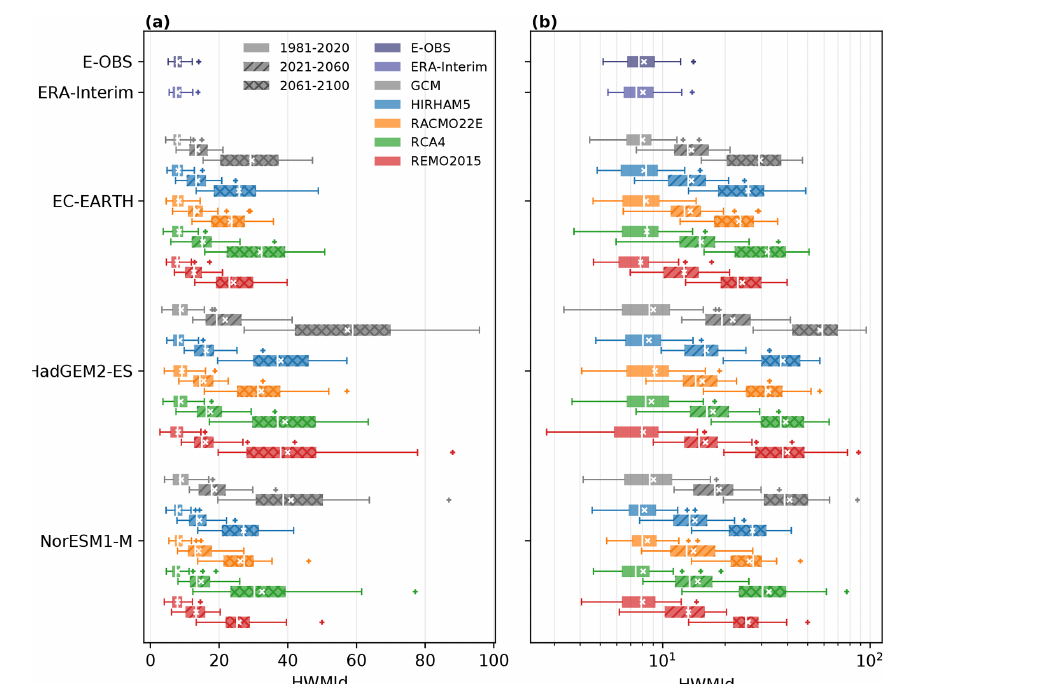
Figure 10. Box-plot for regional mean HWMId values under the defined three periods (indicated by filling patterns) in the simulation matrix of RCMs as well as the driving GCM simulations. Data are presented on different scales: (a) linear, and (b) logarithmic. Within each group (with one GCM), RCMs are identified by colors. Data from E-OBS and ERA-Interim are also shown for comparison under the recent past